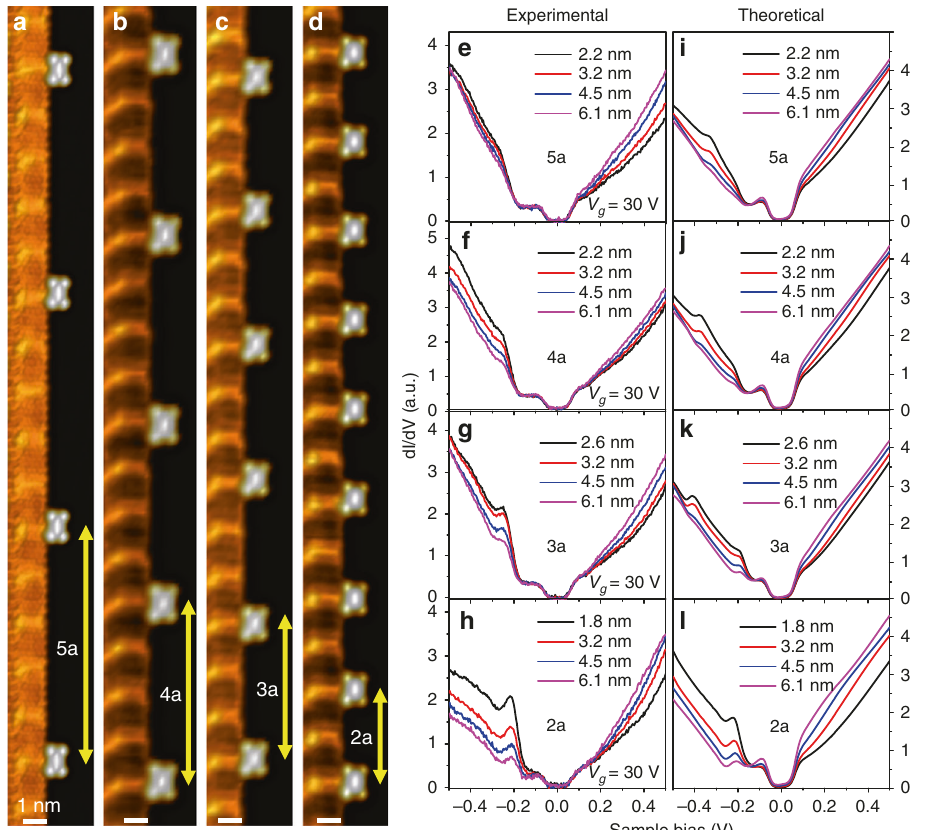
Fig. 2 Emergence of supercritical features in 1D charged molecular arrays. a – d STM images of 1D F 4 TCNQ molecular arrays with tunable periodicity from 5a to 2a (the molecular arrays are anchored to PCDA islands at the surface of a graphene FET, and a = 1.92 nm is the PCDA/graphene moiré lattice constant). e – h dI/dV spectra measured at different distances from the center of an F 4 TCNQ molecule along a line normal to the 1D array axis for charged arrays having different periods as shown in ( a – d ). All spectra were taken at the same back-gate voltage ( V g = 30 V) and tip height. i – l Theoretically simulated dI/dV spectra for equivalent arrays of point charges on graphene at the same probing distances as in the experimental traces shown in ( e – h ). The calculation used an effective valence per molecule of Z = 0.86 and an effective Coulomb screening length λ S = 10 nm, as described in the main text. All experimental data were obtained at T = 4.5